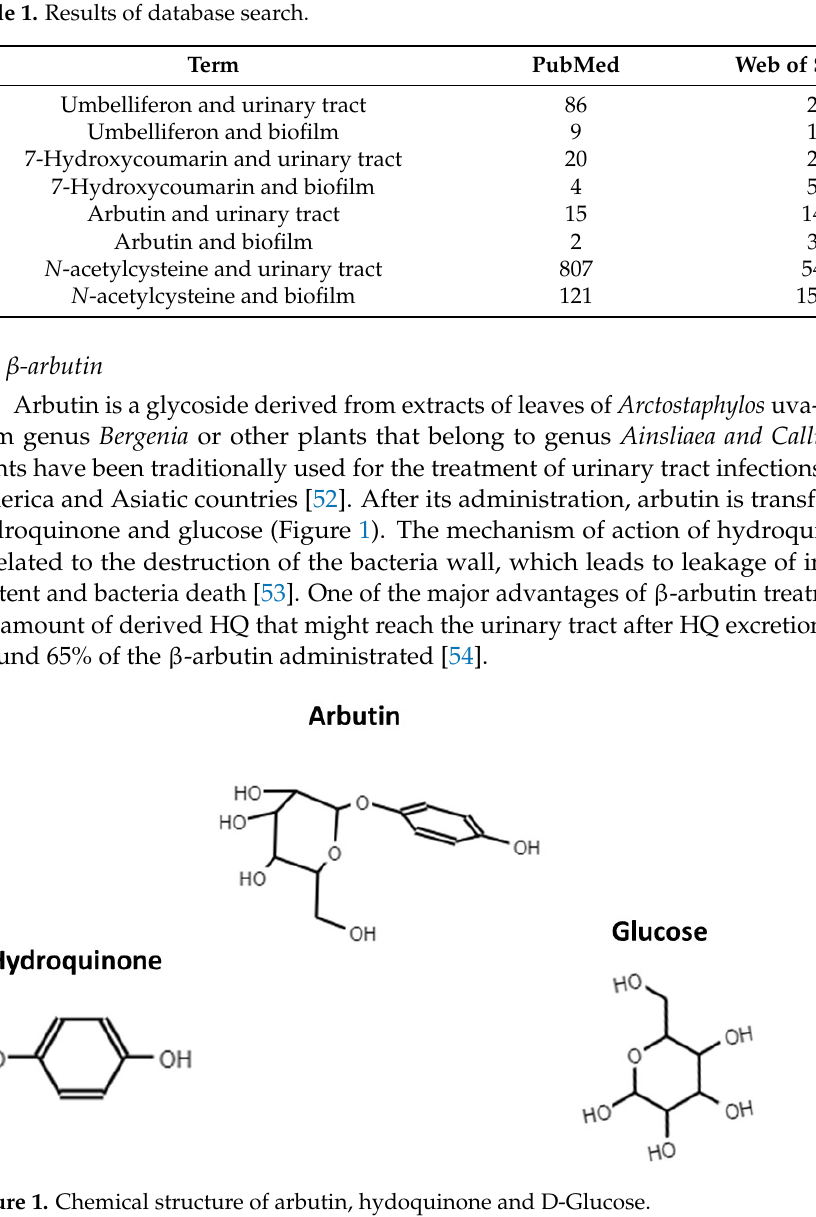
Figure 1. Chemical structure of arbutin, hydoquinone and D-Glucose.